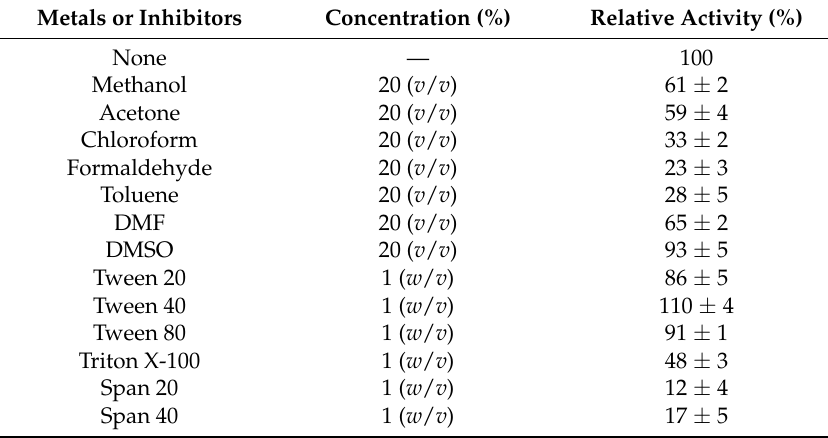
Table 4. Effect of various organic solvent and detergents on the activity of HSPH ZZ a .